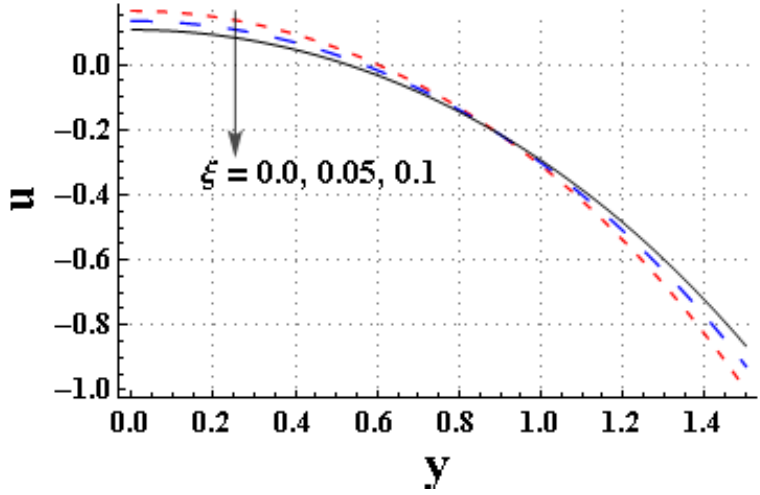
  , on velocity, u . , on velocity, u .